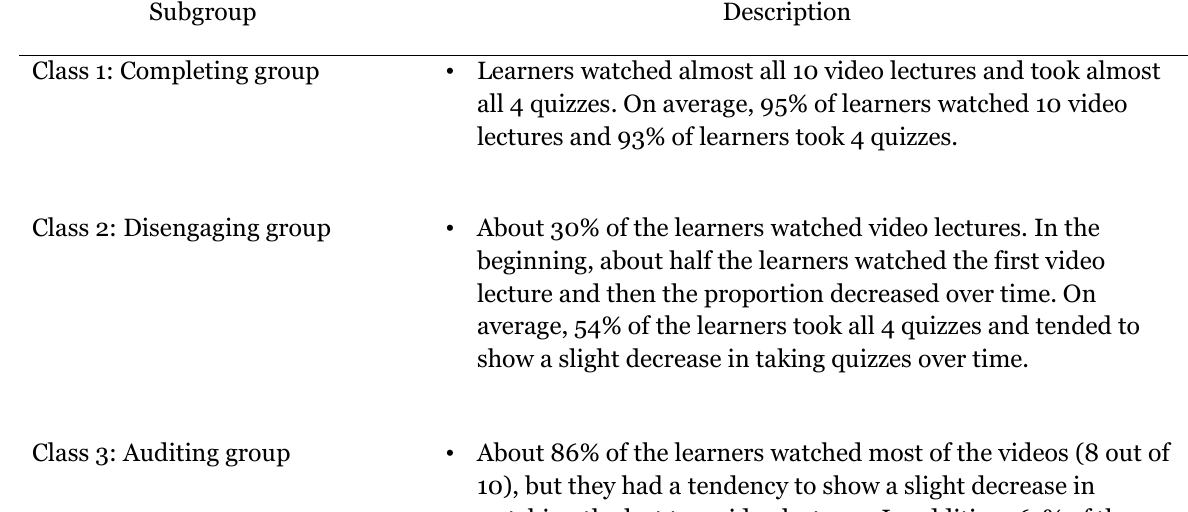
Characteristics of the Five Subgroups Subgroup